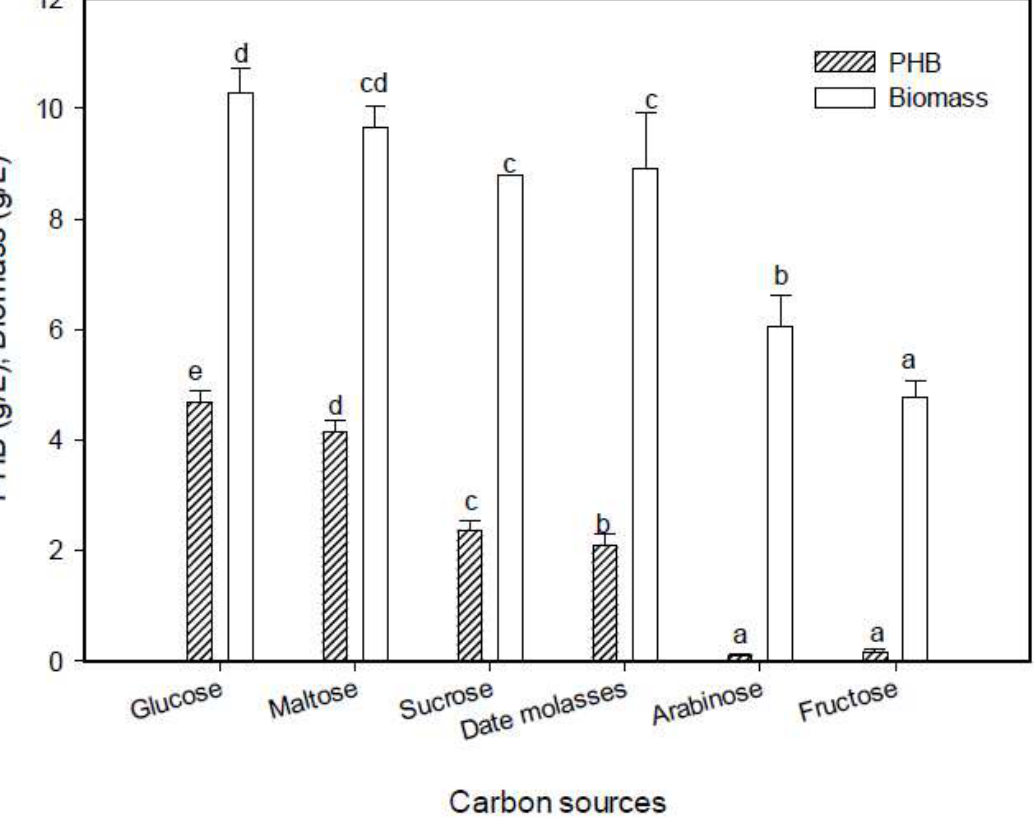
Figure 8. Effect of carbon source on the PHB production by E. aquimaris . The values set by oneself letter(s) on the same column were not significantly different.